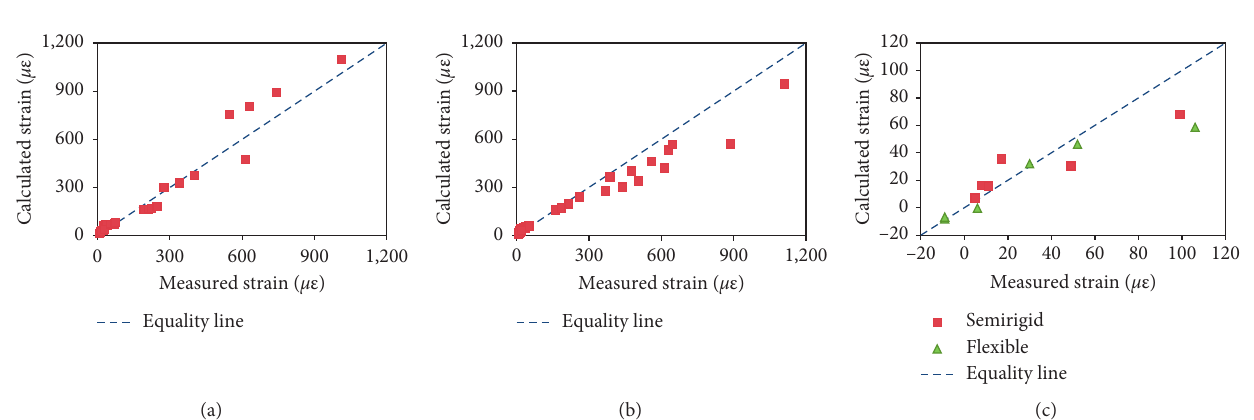
Figure 13: The comparisons between the calculated and measured strains for (a) flexible pavement under vehicular loading, (b) semirigid pavement under vehicular loading, and (c) flexible/semirigid pavements under FWD loading.